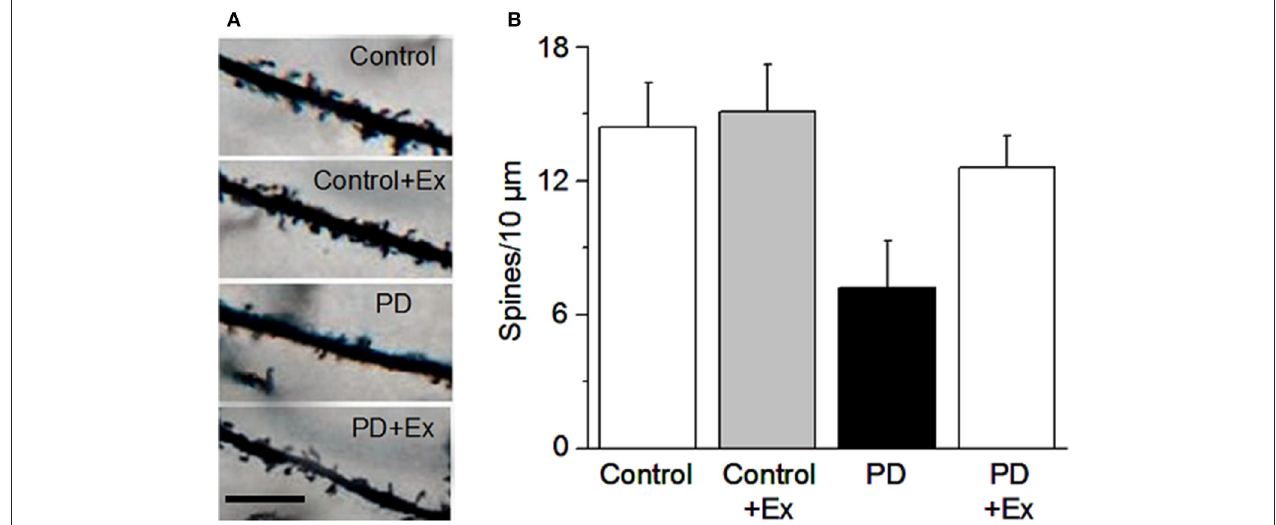
FIGURE 4 | Exercise protects MSN dendritic spines. (A) Example dendritic spines under the four conditions. Scale bar, 5 µ m. (B) Quantification of dendritic spines under the four conditions. Modified from Chen et al. (2015a) with